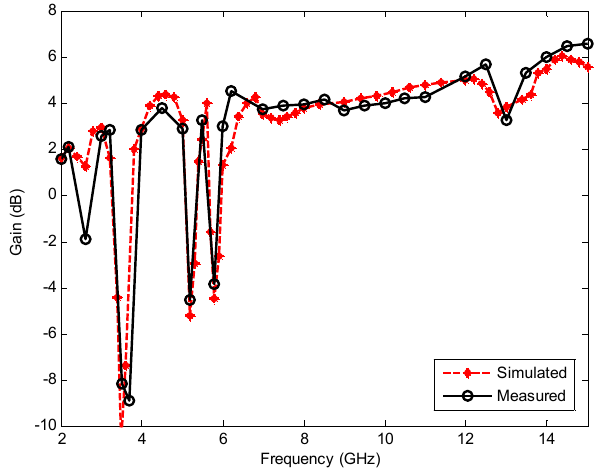
Figure 13. Simulated and measured gain for the proposed triple band-notched UWB antenna.